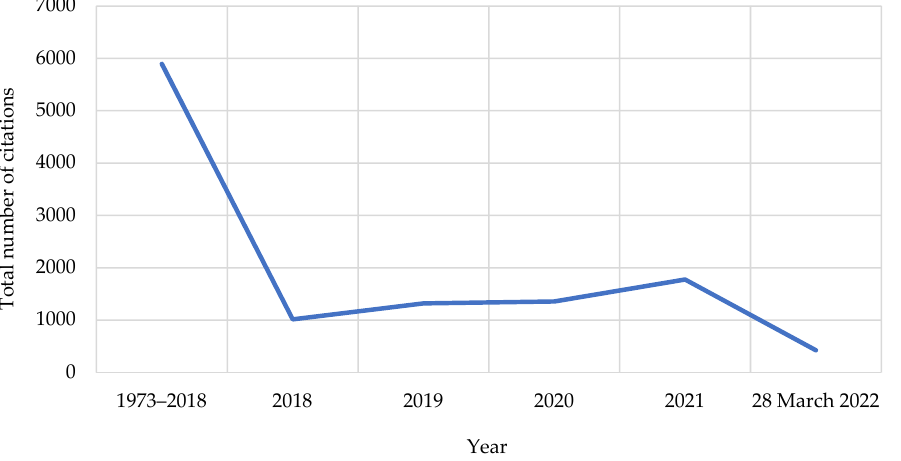
Figure 3. Citations of original research articles on milk fluoridation by year.